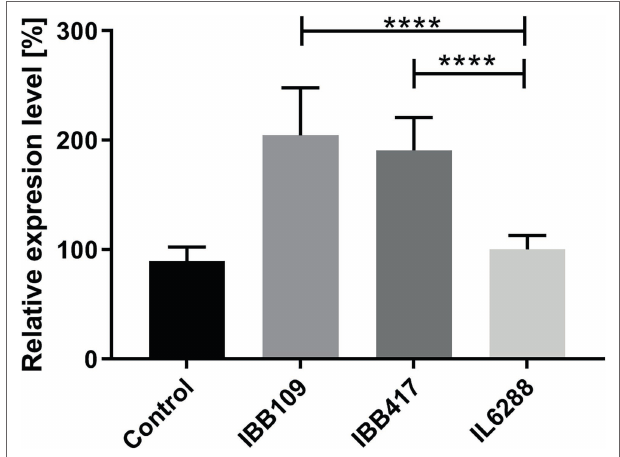
FIGURE 6 | Effect of L. lactis IBB109 and IBB417 strains on interleukin 18 gene expression in Caco-2 cells. L. lactis IL6288 served as a control strain. Gene expression levels were quantified by real-time PCR (RT-qPCR). Relative gene expression levels were normalized against the HPRT host gene. Error bars represent the SE. For statistical analysis, Student’s t -test was used, **** p < 0.0001.